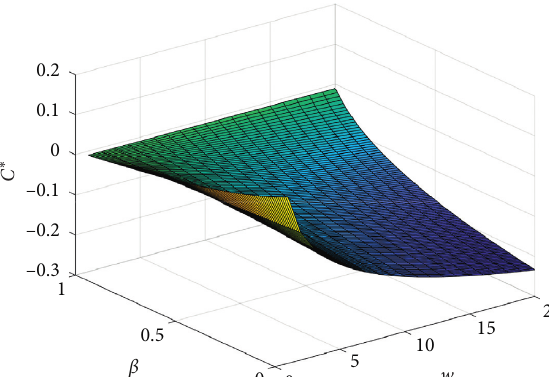
Figure 16: Effect of risk level β and wholesale price w on the optimal inventory cost C ∗ under RMI mode with stochastic demand in the water supply chain.